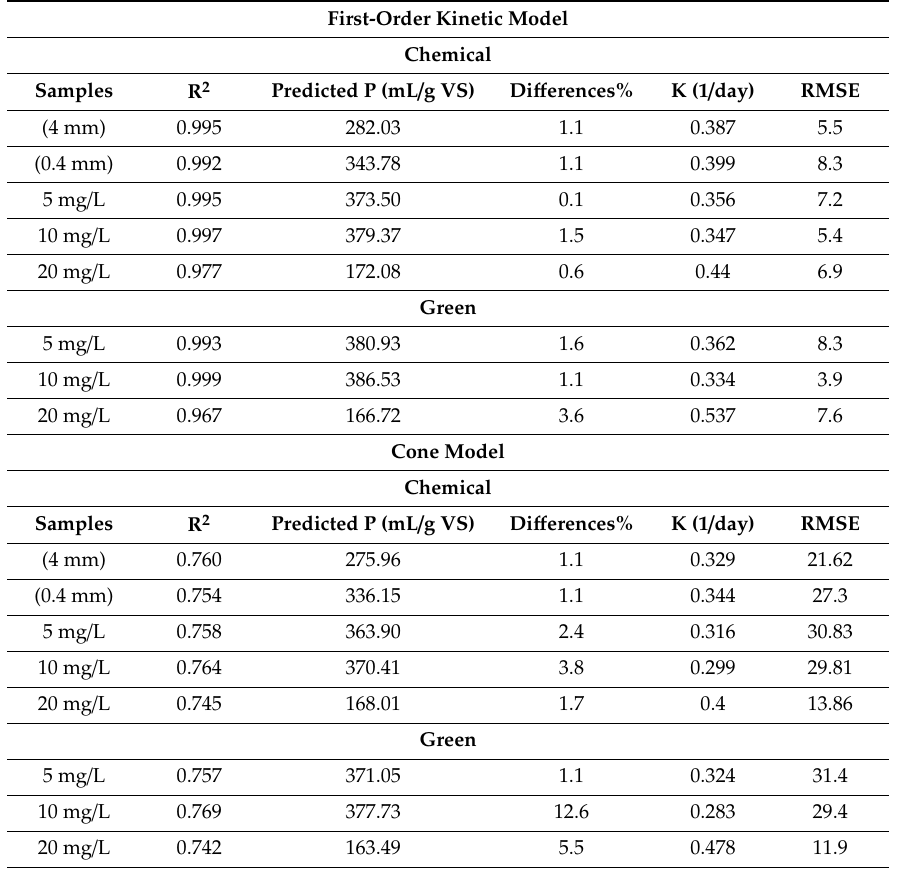
Table 6. Results of the kinetic study using the first order and cone